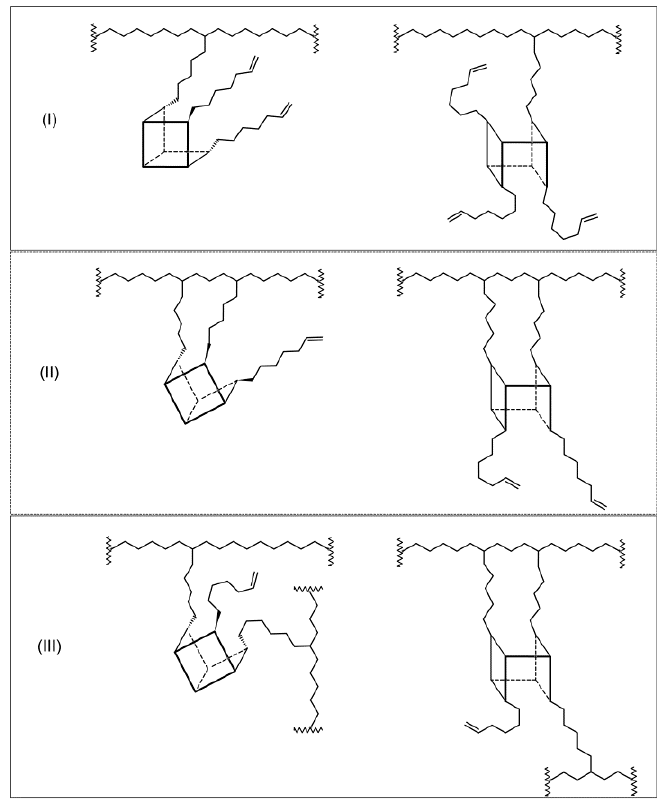
Figure 11. Some possible ways of incorporation of tri- or tetra-alkenyl-POSS comonomers into the polymer chain for ethylene/POSS copolymers: POSS as a pendant group (type I ), intermolecular cyclic group (type II ), and POSS as a cross-linking agent (type III ).